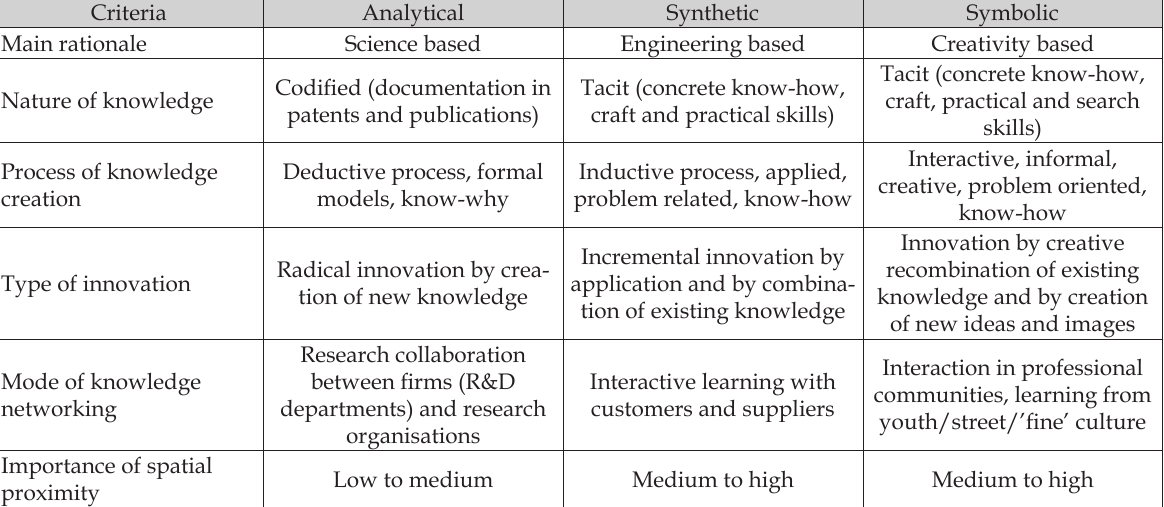
Table 1. Knowledge